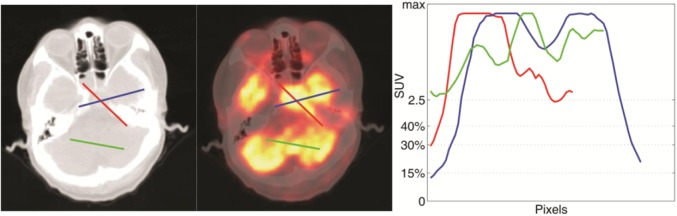
SUV of tumor and surrounding tissuse.On the left side of the figure, two lines are drawn along axial (blue) and radial (red) directions of the lesions. The SUV under the two lines are sampled and shown on the right. SUV15%, SUV30%, SUV40%, SUV2.5 baselines are shown along the Y axis. SUV of lesion and normal tissues reveals many overlapping regions.